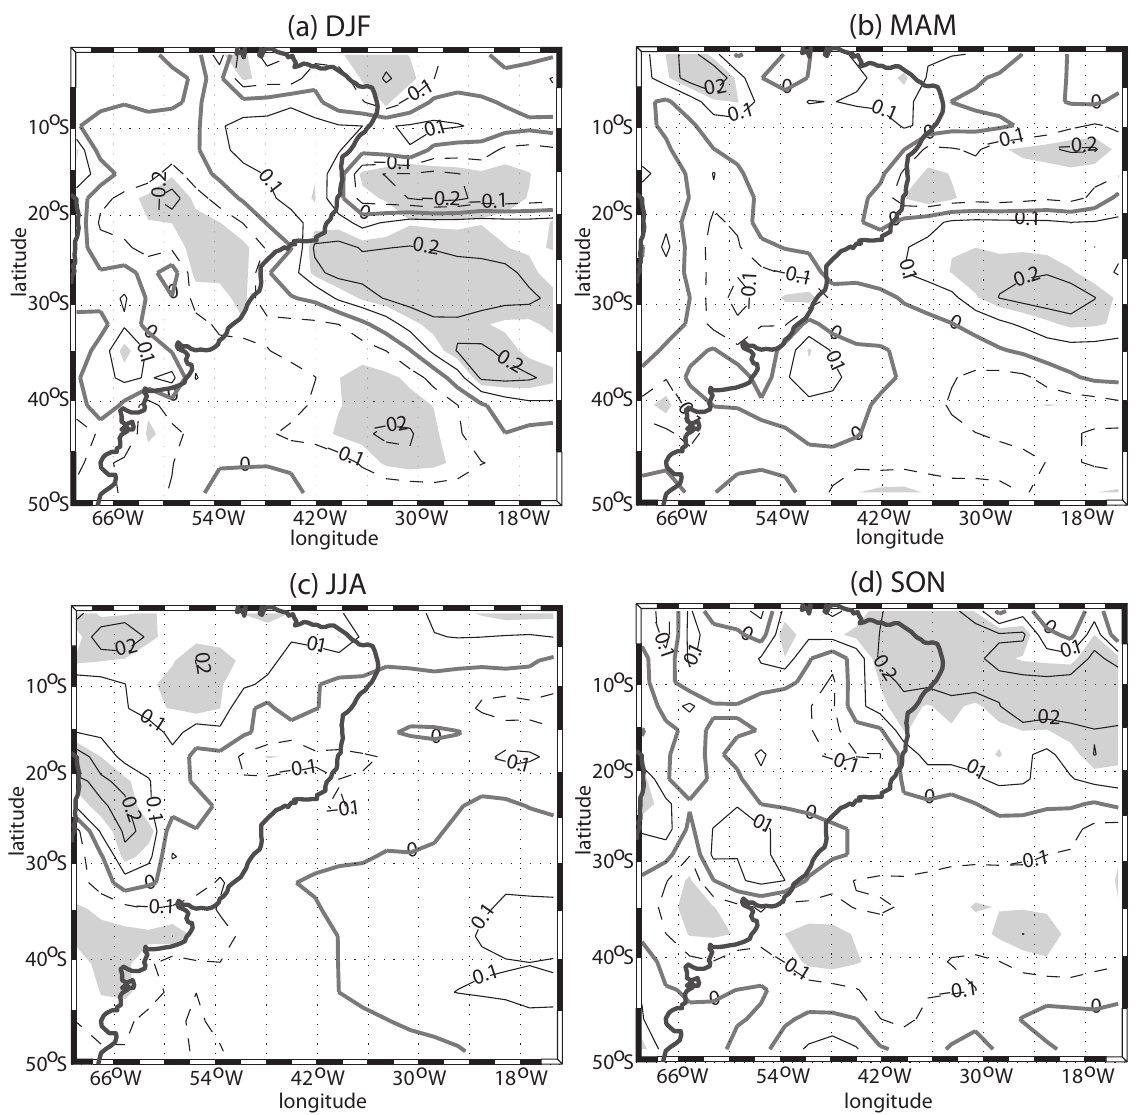
Fig. 7. Spatial distribution of correlation between the Ni˜no3 Index and the simulated precipitation anomalies from EXP2. (a) DJF, (b) MAM, (c) JJA and (d) SON. Correlation coefficients larger than 0.16 are significant at a 95% of confidence